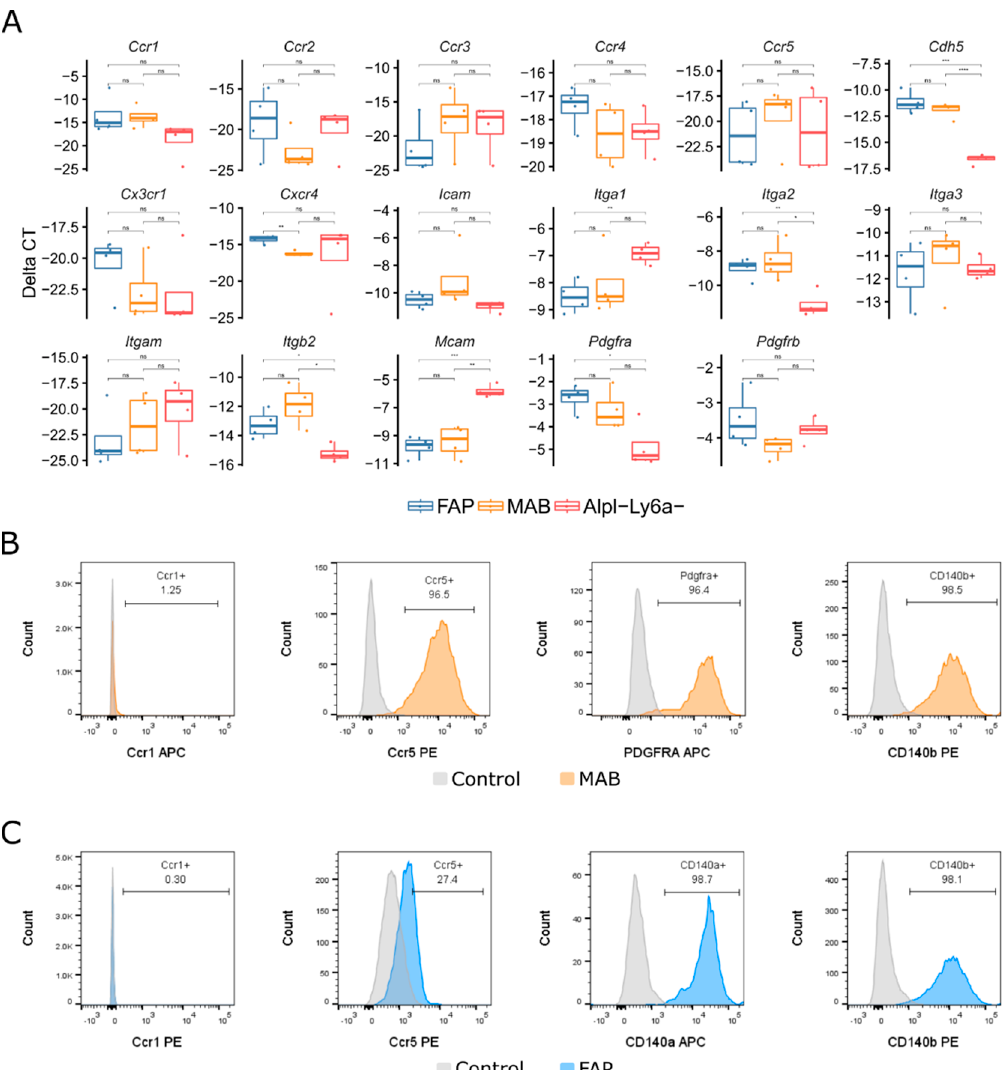
Figure 4. Chemokine receptor screening of interstitial stem cells. ( A ) qPCR analysis of chemokine receptor genes; values shown as ∆ C t, normalized to Rpl13a . n = 4. ( B , C ) Flow cytometry for chemokine receptors localization on murine MAB ( B ) and FAP ( C ). MAB in orange, FAP in blue and unstained control samples in grey. * p ≤ 0.05, ** p ≤ 0.01, *** p ≤ 0.005, **** p ≤ 0.001, t -test.